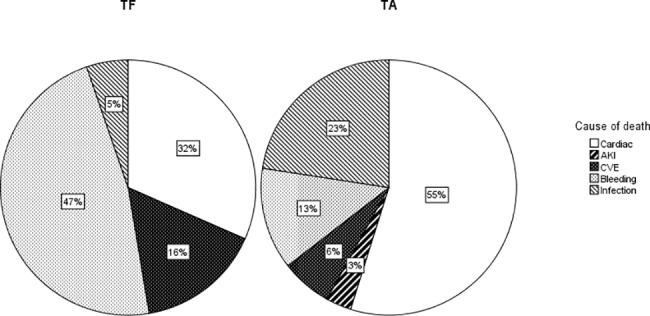
Causes of death (in-hospital) with TF (transfemoral) and TA (transapical) access.All data are presented as percentage. P-values were calculated from raw data: Cardiac (MI, acute heart failure and cardiac arrest): p = 0.148; Acute kidney injury (AKI): p = 1; cerebrovascular events (CVE): p = 0.355; bleeding: p = 0.018; infection: p = 0.134.